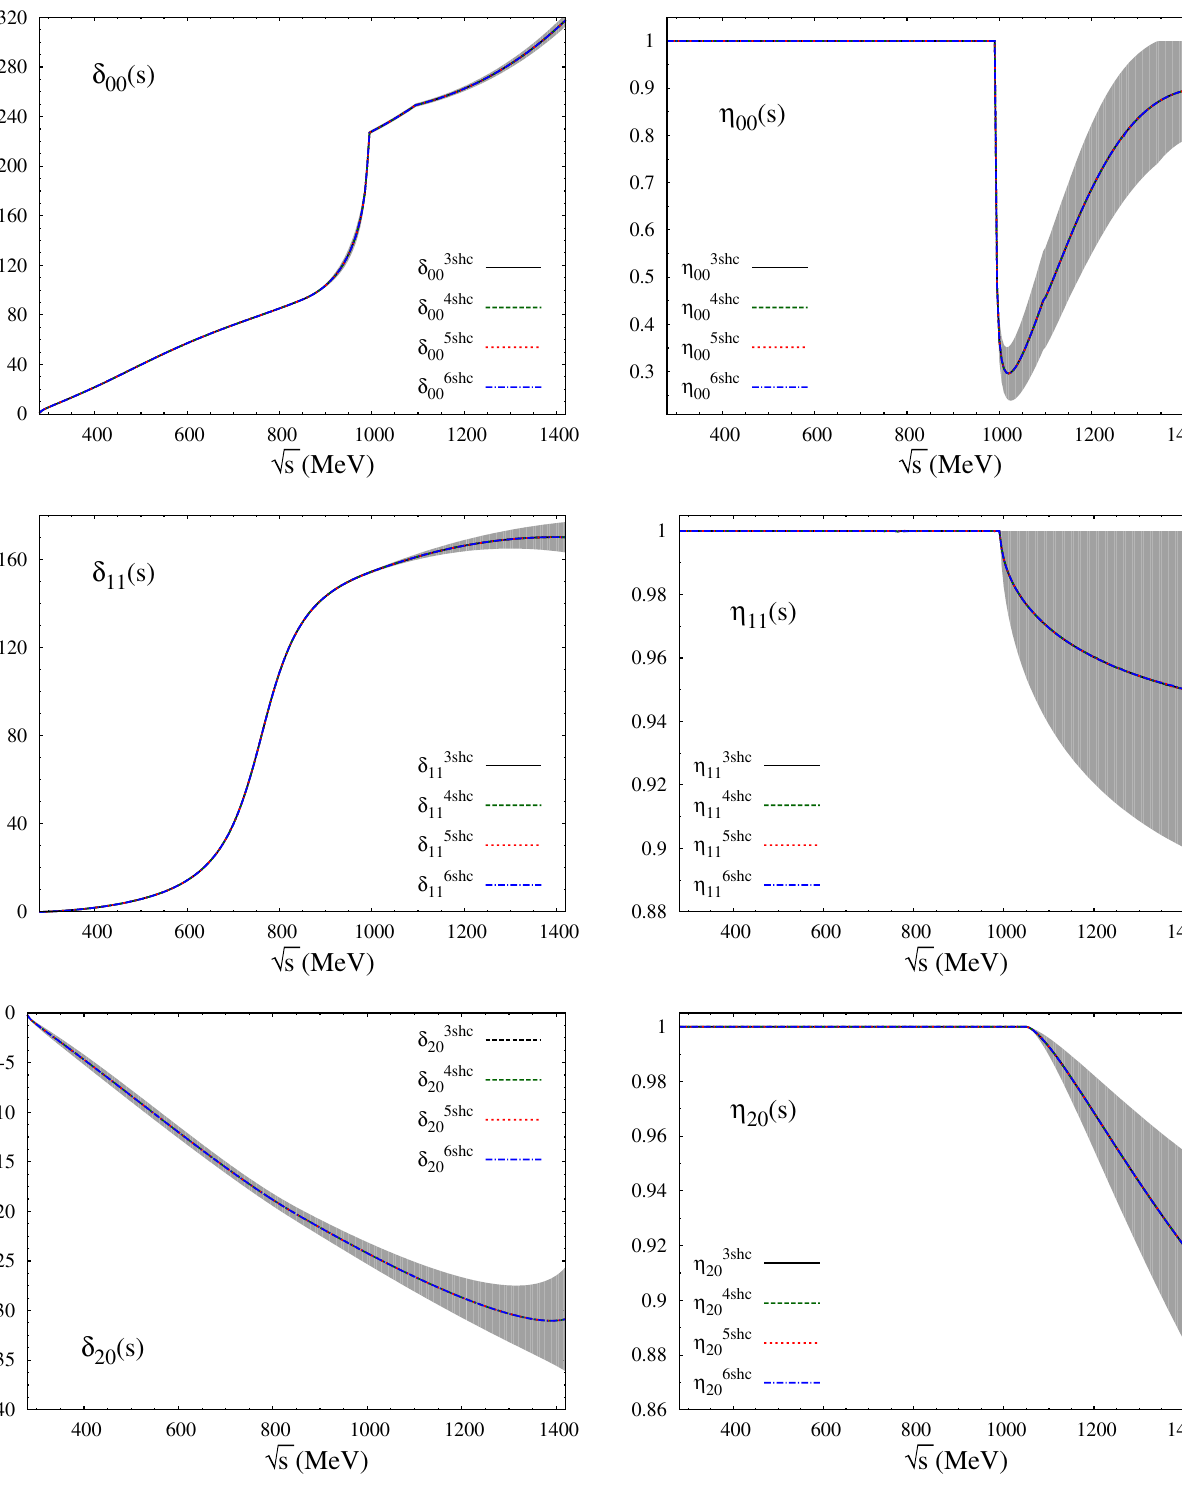
central results for r c = 0 . 9 , 1.2, 1.5 and 1.8 fm, respectively. Neverthe- less, the procedure described in the main text allows one to describe the input exactly at each energy point, so the four lines coincide